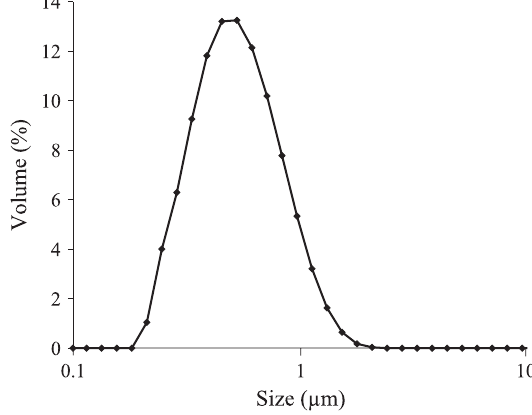
Fig. 9 Size distribution of the synthesized particles.